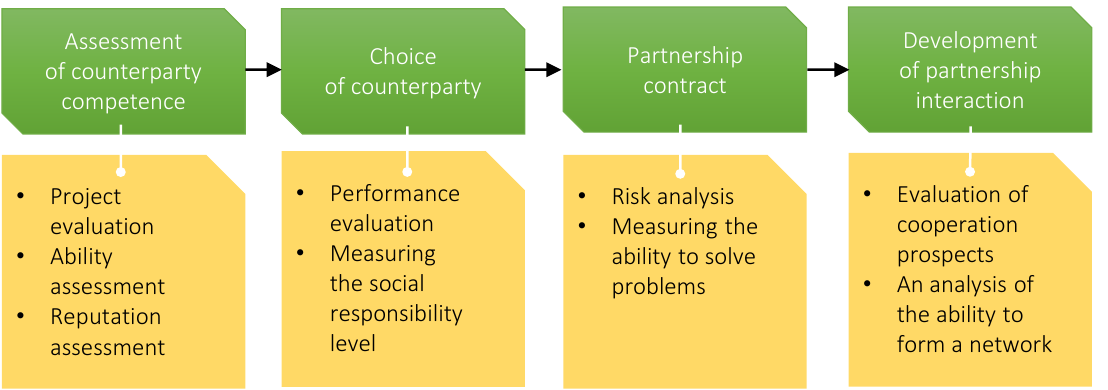
Figure 3. The process of developing trust between